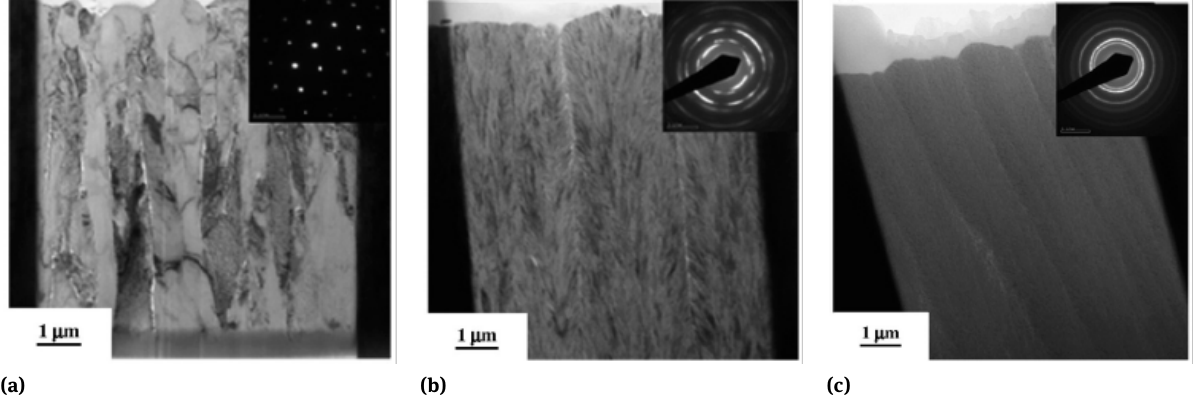
Figure 25: Cross sectional micrograph of with different percentages of Si a) TiN, b) Ti-Si-C-N16% c) Ti-Si-C-N 6% [302]